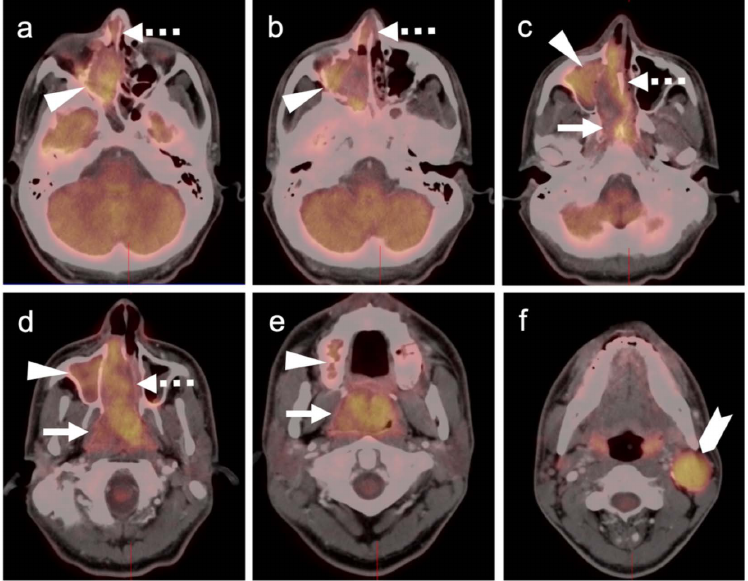
Figure 20. Nasopharyngeal rhabdomyosarcoma. Multiple axial FDG PET-CT images of the head. Extensive and nasopharyngeal rhabdomyosarcoma. ( a – e ) Tumor fills the right ethmoid and right maxillary sinuses (white arrowheads); ( c , d ) Tumor fills the nasal cavity (dashed white arrows); ( c , d ) Tumor also fills the nasopharynx (white arrow); ( f ) There is also involvement of a left level 2 enlarged cervical node (white